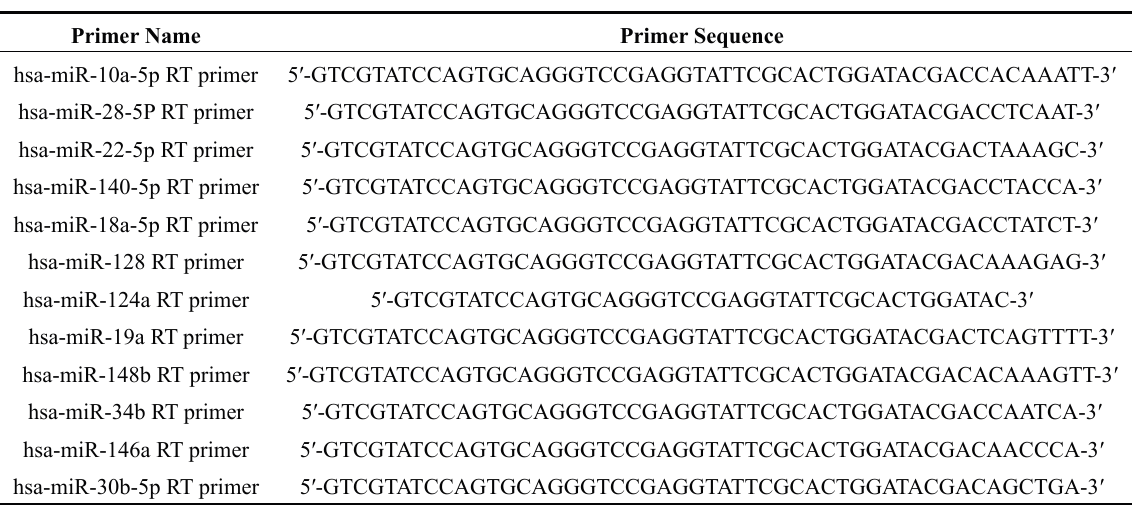
Table 3. Primer for reverse